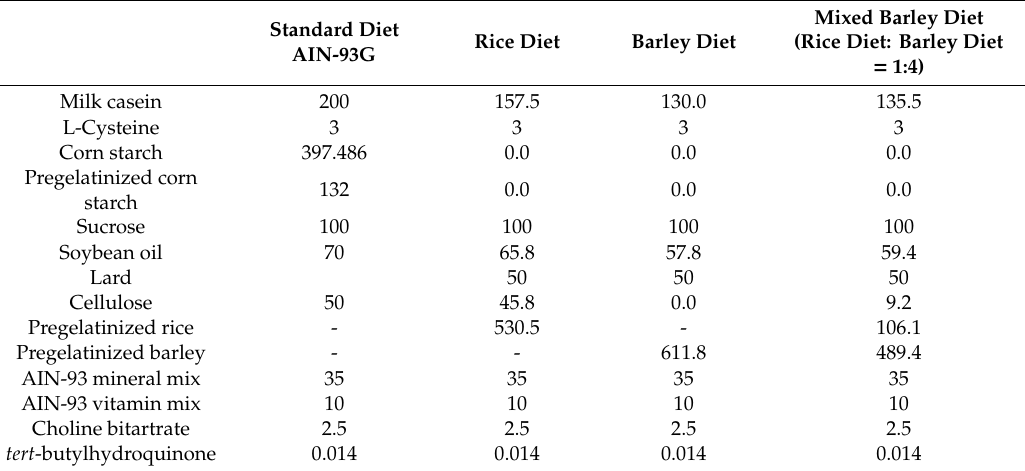
Table 1. Composition of the standard, rice, and barley diets.